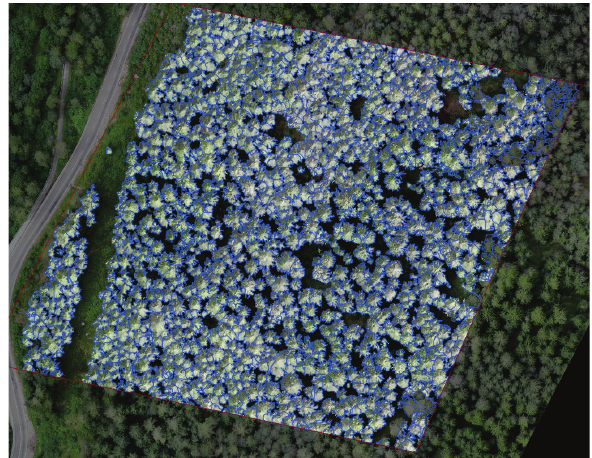
Figure 3. Tree delineation using UAV-CHM